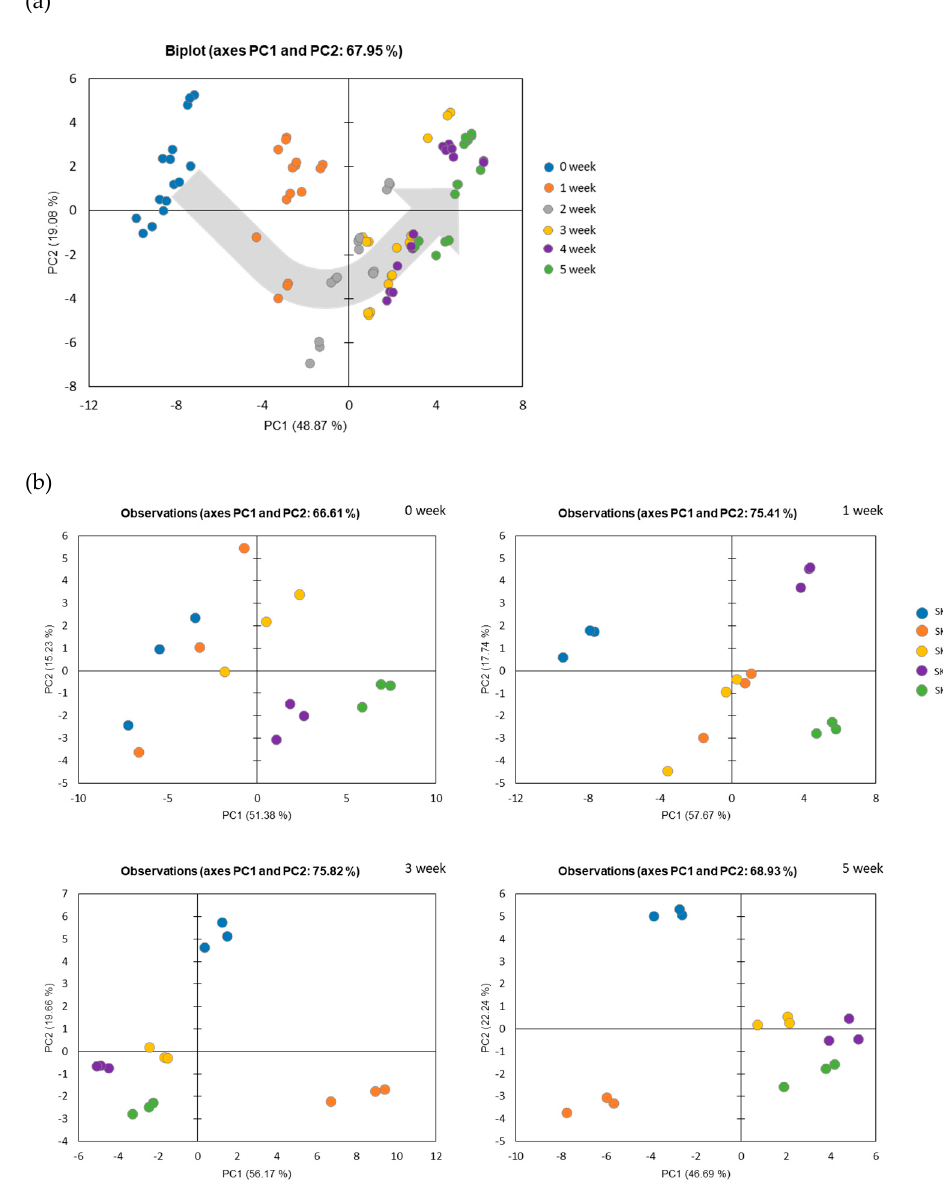
Figure 6. PCA score plots derived from metabolite data of kimchi samples fermented at different salinities. ( a ) PCA score plots derived from metabolite data for each day of fermentation. ( b ) PCA score plots derived from metabolite data for kimchi with different salinities at 0, 1, 3, and 5 weeks of fermentation. PCA, principal component analysis.